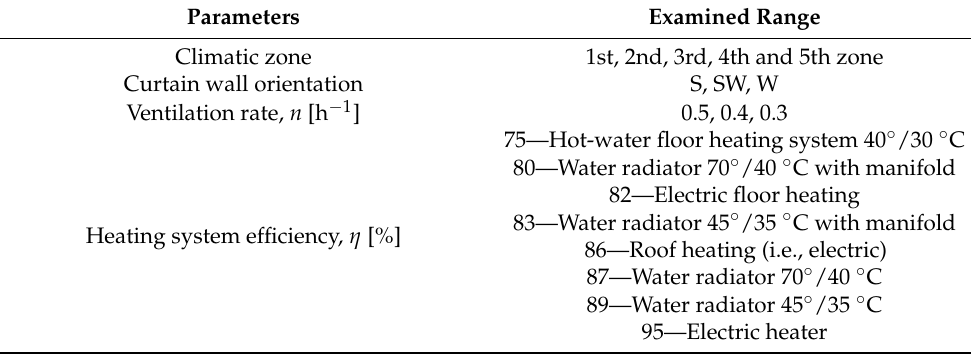
Table 7. The parametric data for the considered case